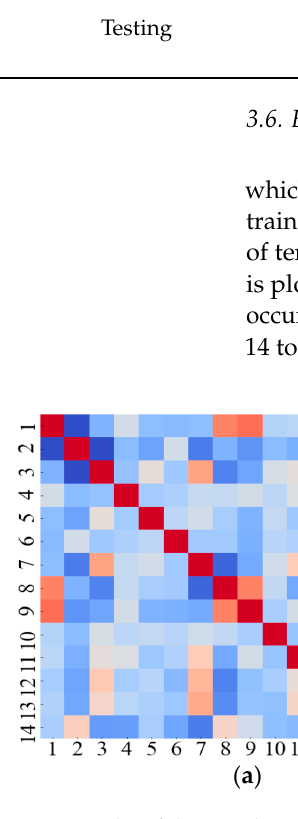
Figure 8. Results of the correlation matrices for input variables: ( a ) before PCA dimensionality reduction, and ( b ) after PCA dimensionality reduction.